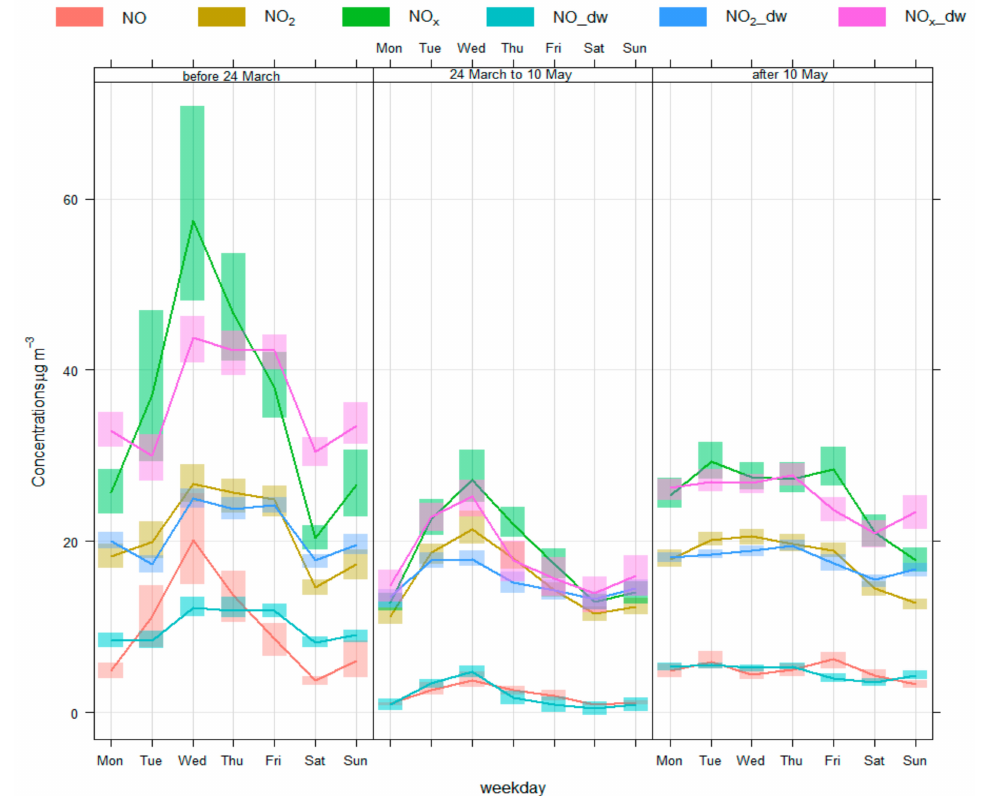
Figure 4. Weekly cycles of NO, NO 2 , and NOx for pre-lock down, lock-down, and post-lockdown periods at Devonshire Green AQMS in